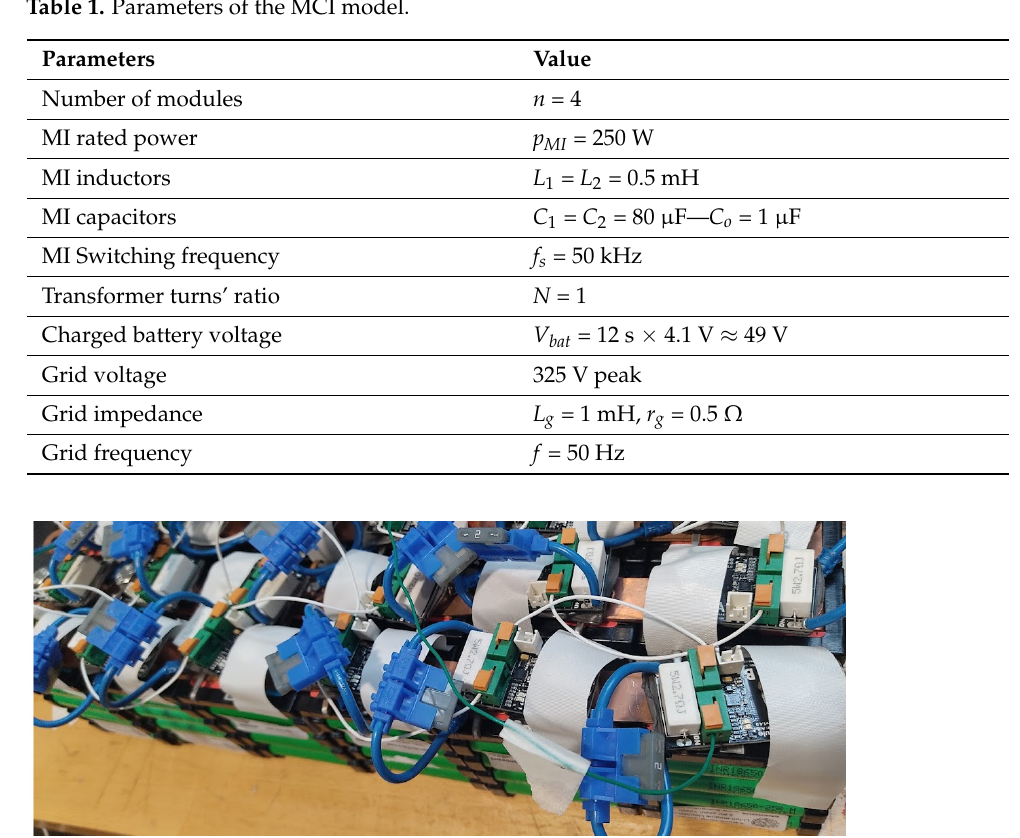
Figure 15. Battery segments. Table 1. Parameters of the MCI